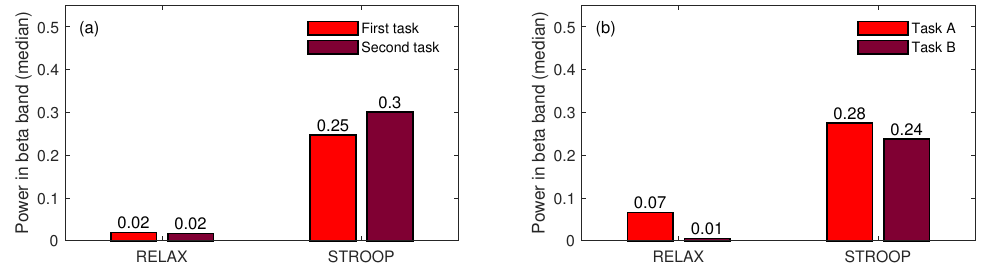
Figure 8. The comparison of medians for RELAX and STROOP events arranged in time ( a ), arranged according to tasks ( b ).